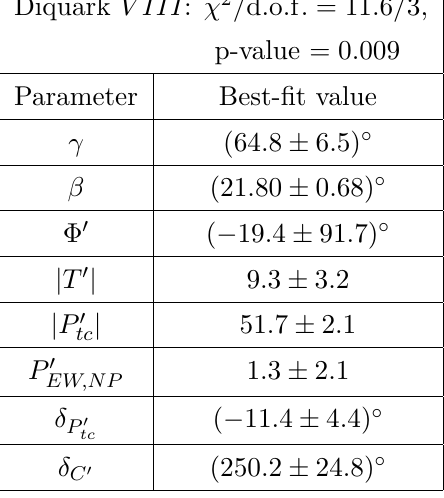
Diquark V III : (cid:31) 2 = d : o : f : = 11 : 6 = 3,